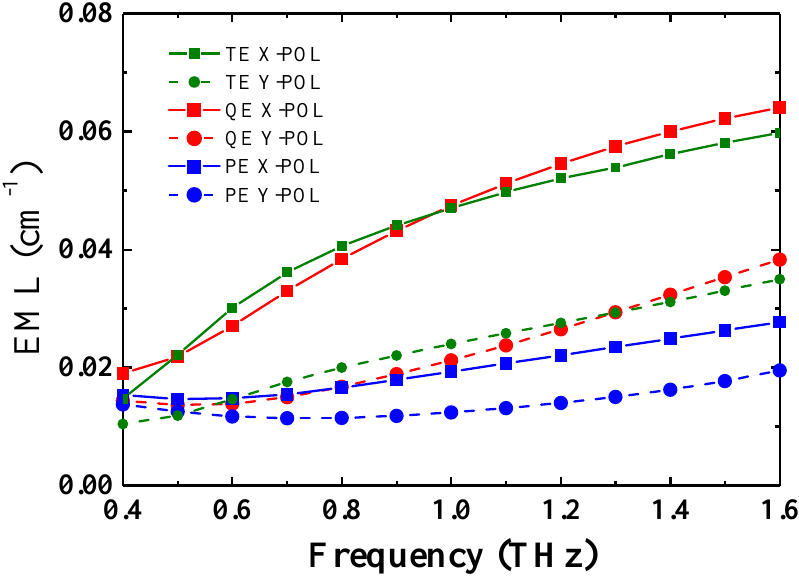
Figure 7. Response of effective material loss (EML) to frequency for the TE, QE, and PE designs.